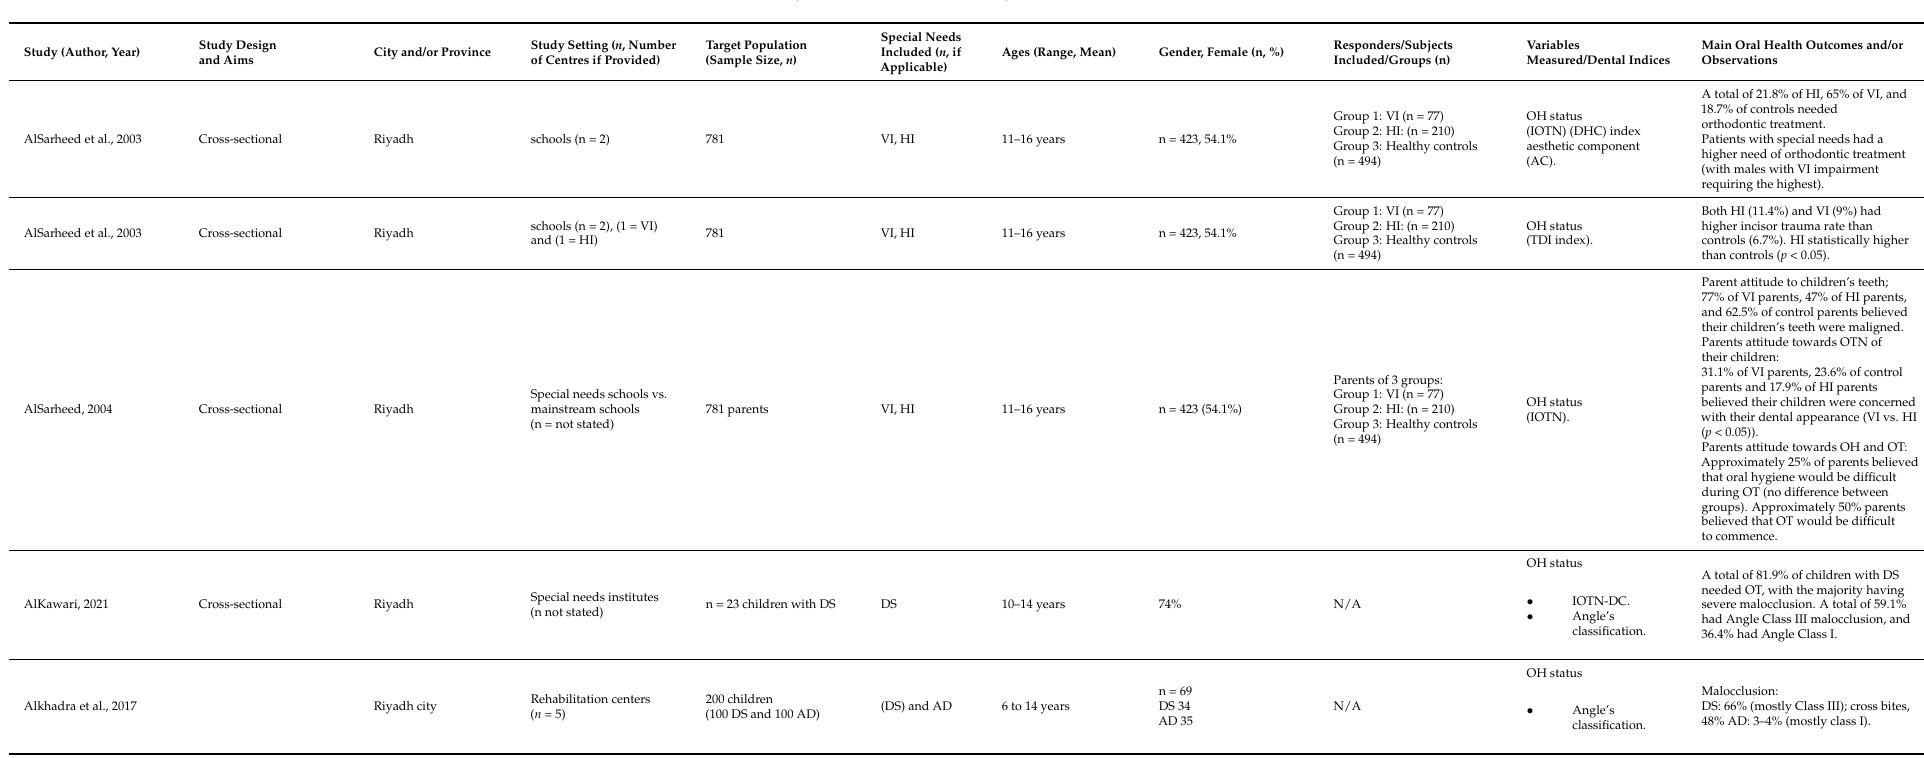
Table 1. List of studies about oral health status, oral health behavior, and oral health care